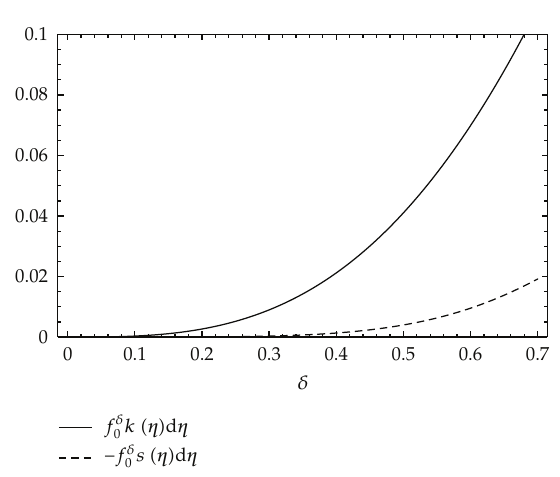
(cid:23) δ k (cid:3) η (cid:4) dη (cid:4) and the normalized lateral flow rate (cid:3) 0